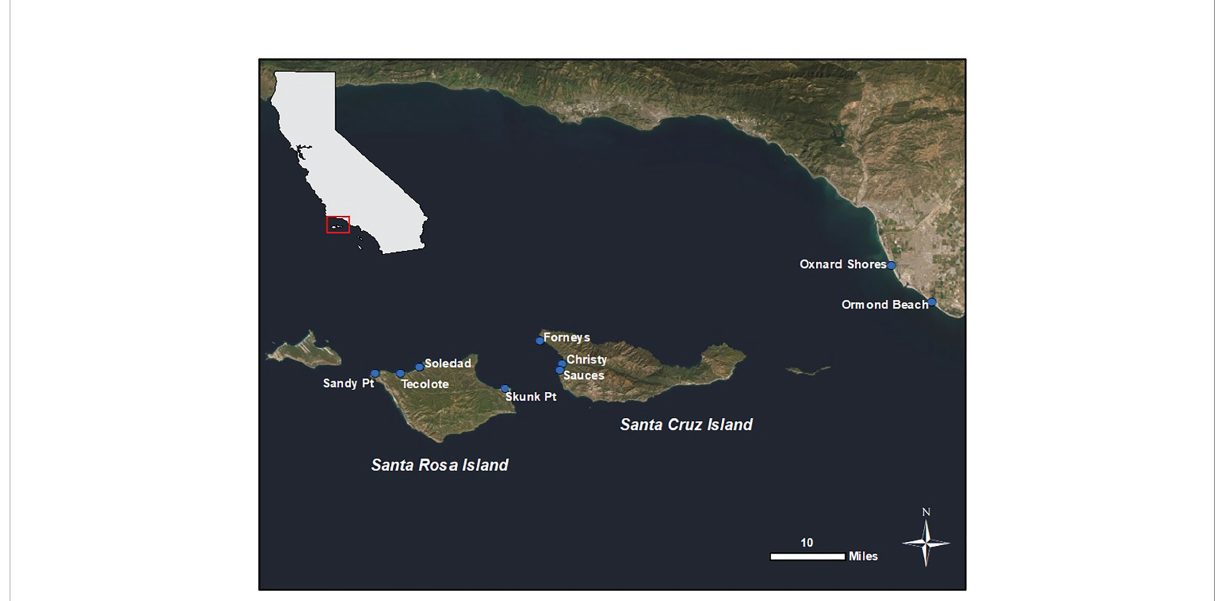
FIGURE 1 Location of marine debris monitoring and removal sites on two islands within the Channel Islands National Park and on the Ventura County Mainland, California, USA. Santa Rosa Island sites were Sandy Point (SAN), Tecolote Canyon (TEC), Soledad Canyon (SOL) and Skunk Point (SKP). Santa Cruz Island sites were Forney ’ s Point (FOR), Christy ’ s Beach (CHB) and Sauces (SAU). Two sites on the Ventura County mainland were Oxnard Shores (OXN) and Ormond Beach